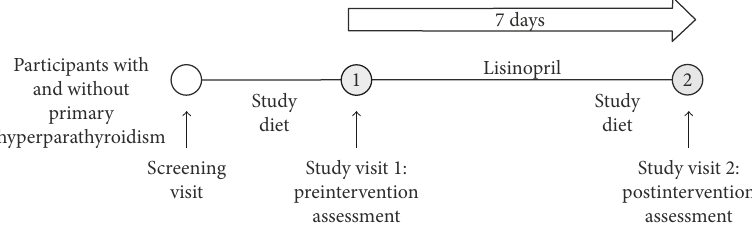
Figure 1: Study schema.